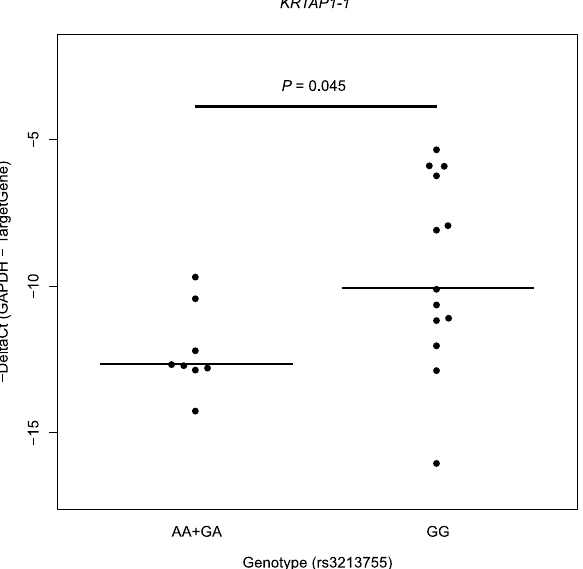
Figure 2. The loss-of-function variant, rs3213755, leads to low expression of the KRTAP1-1 gene in brain tissues. Expression levels are presented as minus ΔCt ( GAPDH Ct value—TargetGene Ct value). Statistical analysis was performed using Wilcoxon’s rank-sum test. The association test was considered as a dominant model for the minor allele (A). Statistical analysis was performed using Wilcoxon’s rank-sum test. One sample with extremely high expression was excluded from the statistical analysis as an